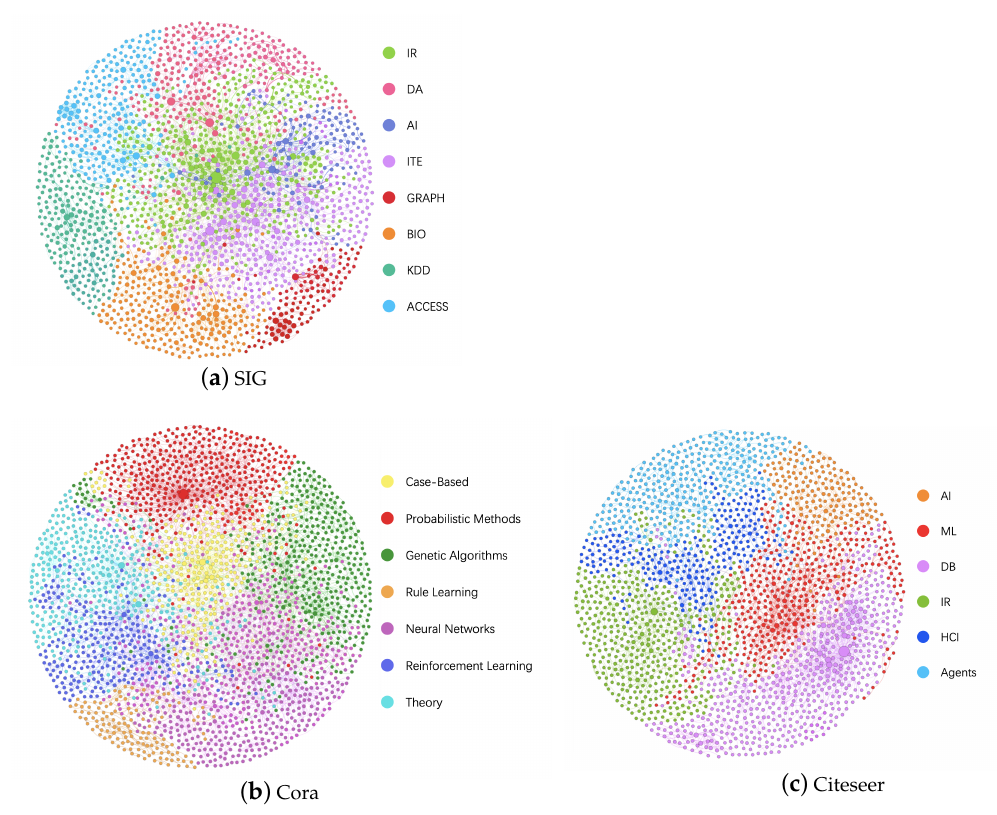
Figure 6. The networks constructed for the three datasets. ( a ) SIG scholar collaboration network. ( b ) Cora citation network. ( c ) Citeseer citation network. In the networks, different colors represent different categories, and the size of a node represents its influence on other nodes.